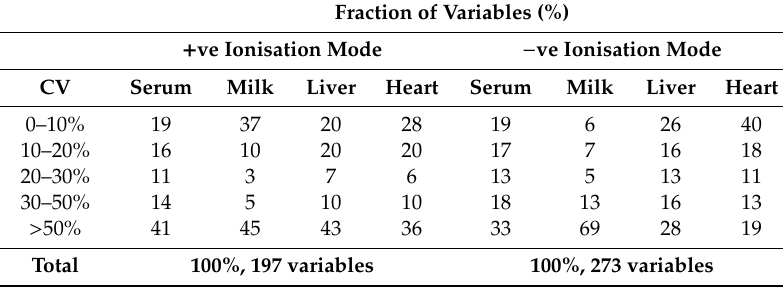
Figure 3. Principal component analyses of lipid signals from organically-soluble extracts of pooled murine hearts and four animal milks. Panel A , lipid signals from commercial animal milks in positive ionisation mode; B , lipid signals from commercial animal milks in negative ionisation mode; C , lipid signals from murine hearts in positive ionisation mode; D , lipid signals from murine hearts in negative ionisation mode. Murine hearts were drawn from two pools of individuals each from two phenotypes. Coefficient of variance (CV) values are shown in Table 1 and in Supplementary information. Table 1. Variables stratified by parameters for chemical structures. The proportion (%) of variables in strata of variance for each of four matrices. Coe ffi cient of variance calculated from the standard deviation of 16-20 samples of each of four groups, divided by the mean for the same group. Milk samples and human serum were drawn from four di ff erent commercial sources (Milk1, un-homogenised Jersey milk; Milk2, whole caprine milk; Milk3, soya ( Glycine max ) drink; Milk4, whole, homogenised bovine milk). Murine heart and liver samples were drawn from two pools of two feeding phenotypes. Fraction of Variables